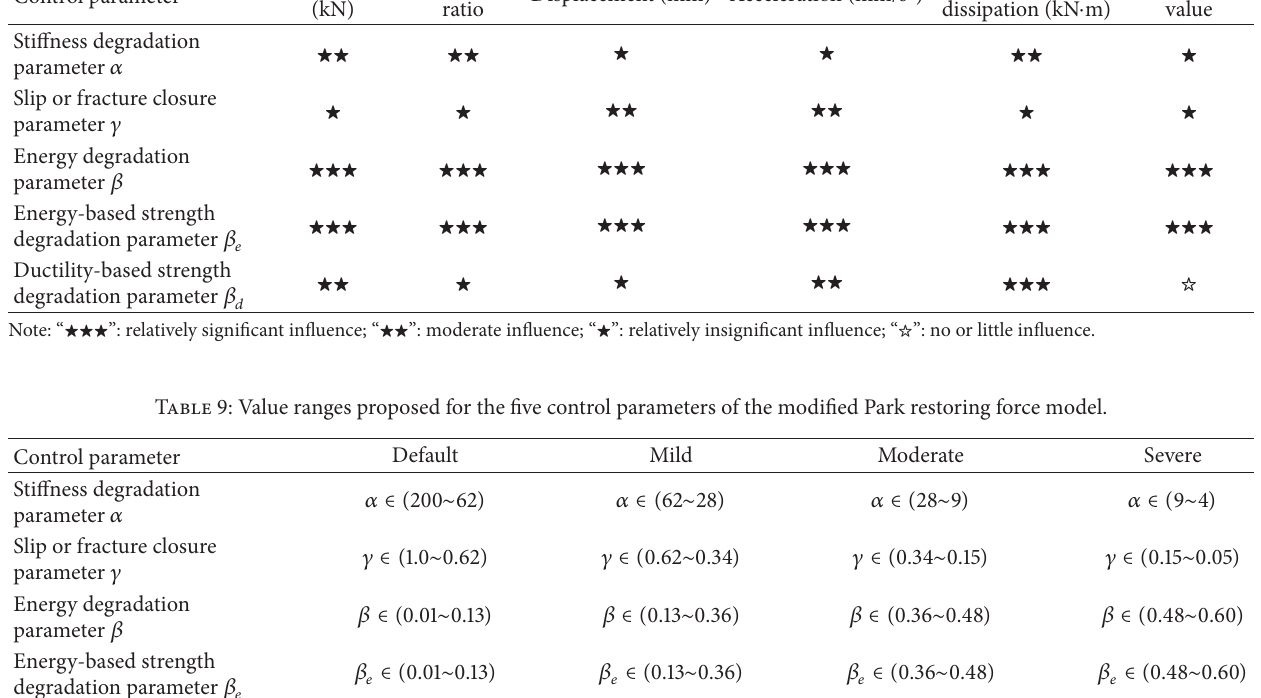
Table 8: Influence of the five control parameters of the modified Park restoring force model on structural responses. Control parameter